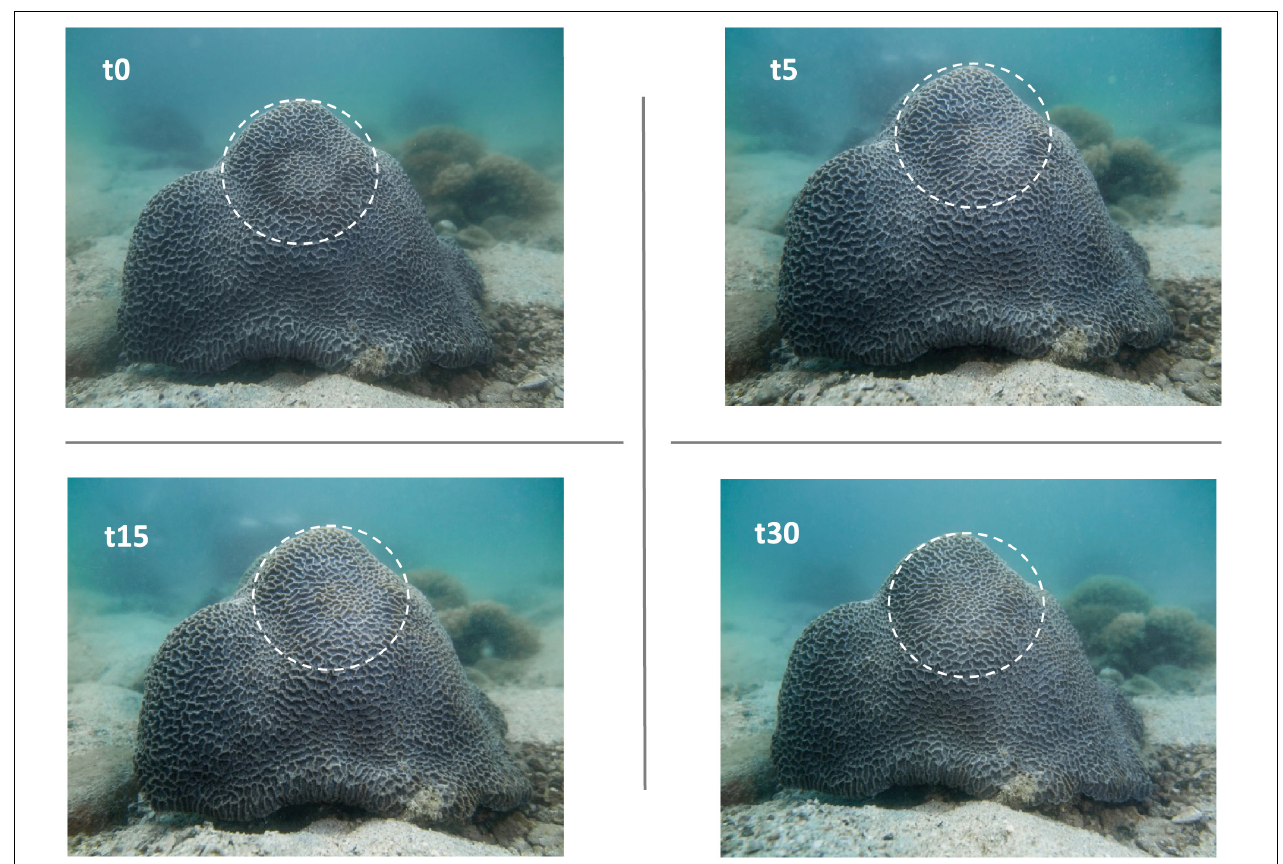
FIGURE 4 | The CISME neoprene ring leaves a visible mild discoloration on the coral tissues on removal (t = 0). This visible spot disappears completely within 30 min after deployment, indicating there is no longer term coral stress. The same is true after multiple measurements of the same spot on the corals (see Figure 6A ).